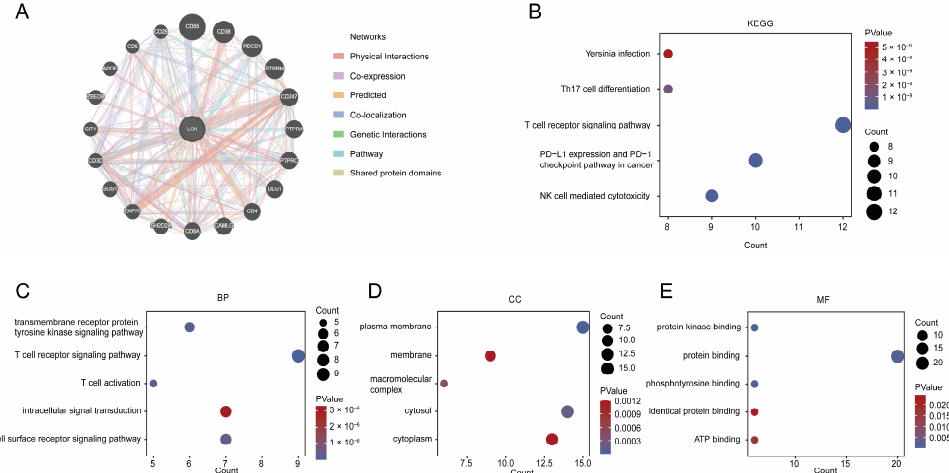
Figure 10. Protein–protein interaction network and pathway enrichment of LCK. ( A ) The proteins interacting with LCK based on the reported associations according to the GeneMANIA database.